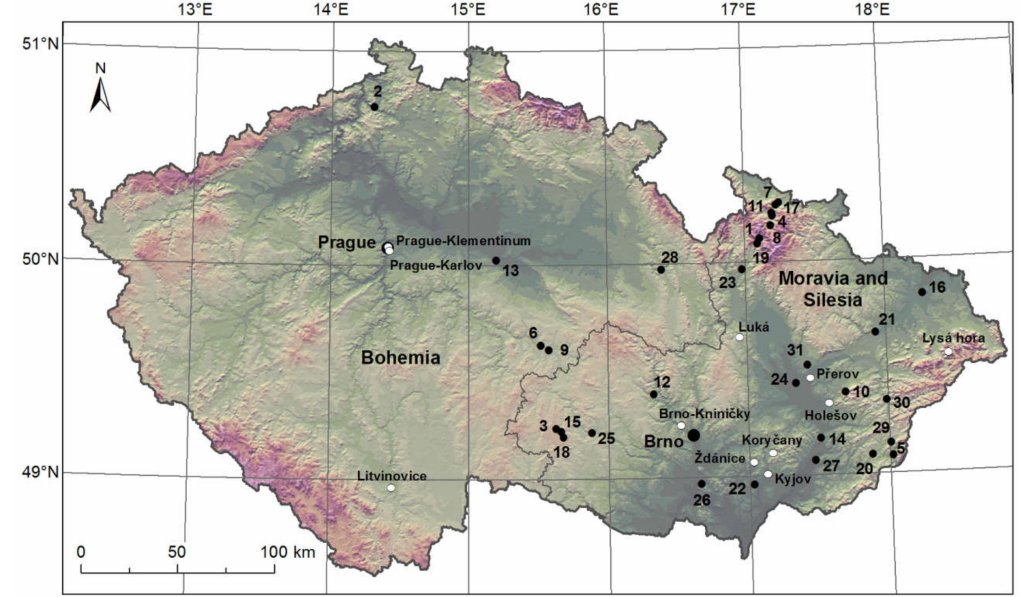
Figure 2. Meteorological stations (circles) and locations (points with numerals) in the Czech Republic mentioned in this paper (given in an alphabetical order): 1—Ann í n (today Louˇcn á nad Desnou), 2—Benešov nad Plouˇcnic í , 3—Brtniˇcka, 4—Bukovice (today Jesen í k), 5—Bylnice